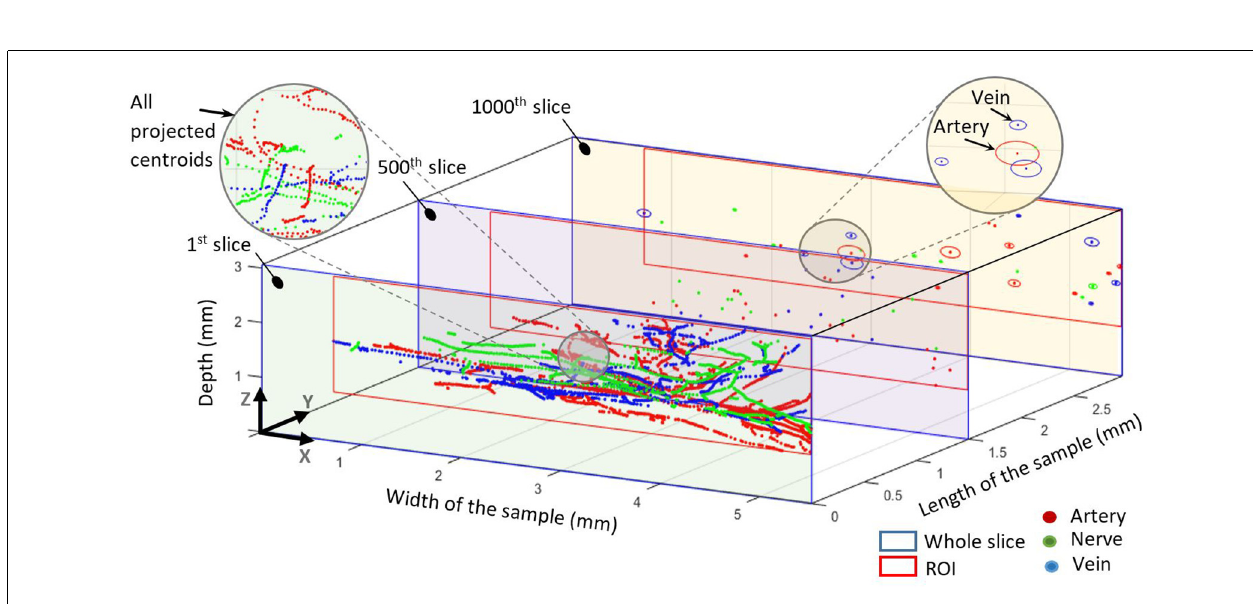
FIGURE 4 | All centroids mapped into the first slice. The 500th slice at 1.5 mm shows all centroids in this slice for all elements. The 1,000th slice at 3 mm shows the centroids and elliptical outlines of each element. The blue outline represents the whole slice whereas the red outline represents the common region of interest for each